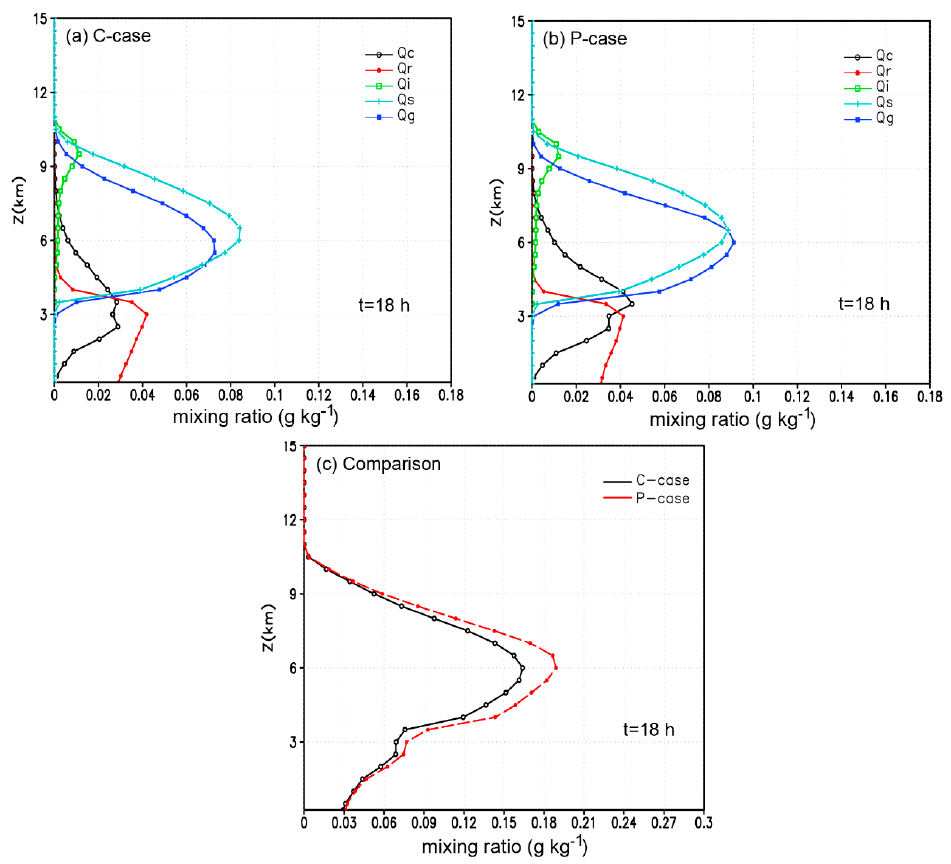
Figure 6. Same as Figure 5, but for t = 18 h.